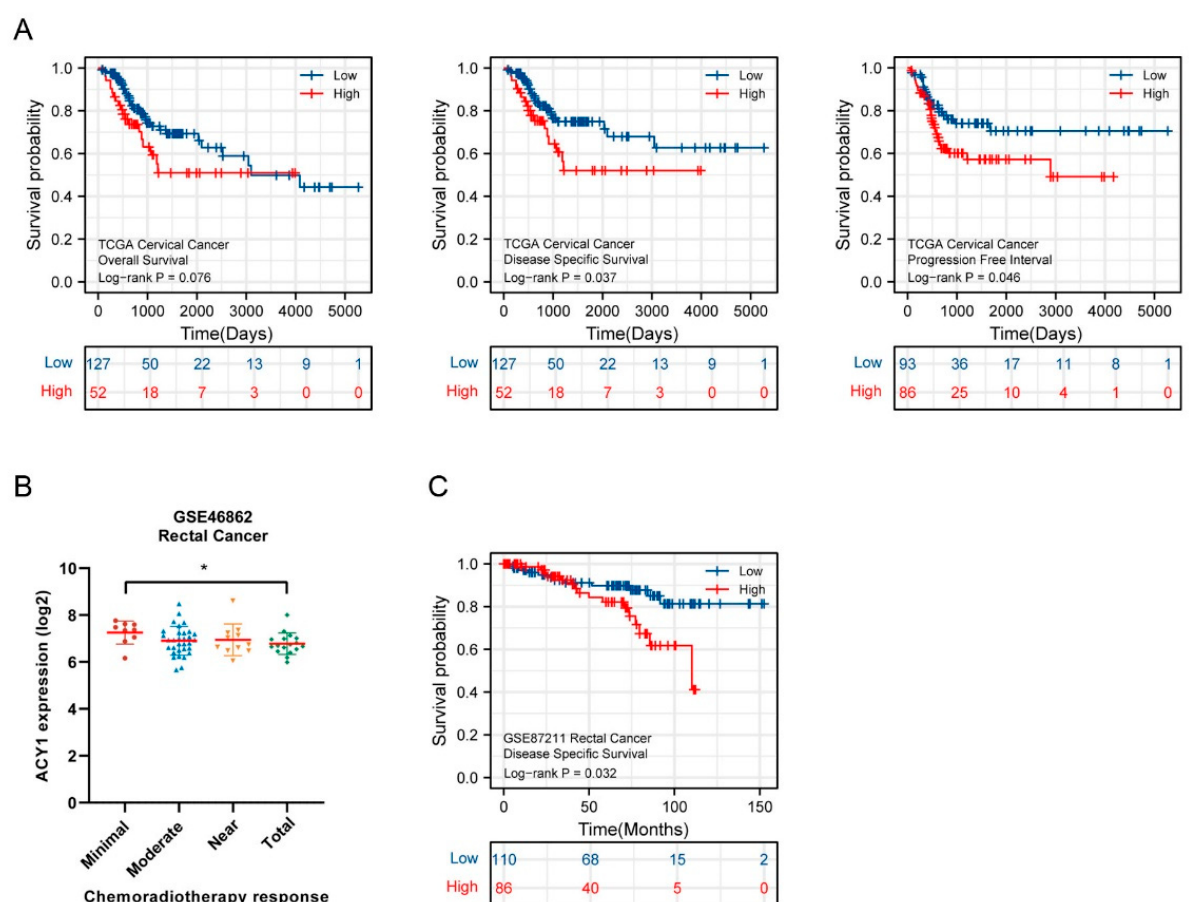
Figure 4. High ACY1 expression predicts poor efficacy of radiotherapy and worse prognosis in patients with cervical or rectal cancer. ( A ) Kaplan–Meier analysis of OS, DSS and PFI in cervical cancer patients with radiotherapy based on ACY1 expression from TCGA datasets. ( B ) The relationship between the expression of ACY1 and the response to chemoradiotherapy in rectal cancer patients from the GSE46862 dataset. ( C ) Kaplan–Meier analysis of DSS in rectal cancer patients based on ACY1 expression from the GSE87211 dataset. OS, overall survival; DSS, disease-specific survival; PFI, progression ‐ free interval. * p < 0.05